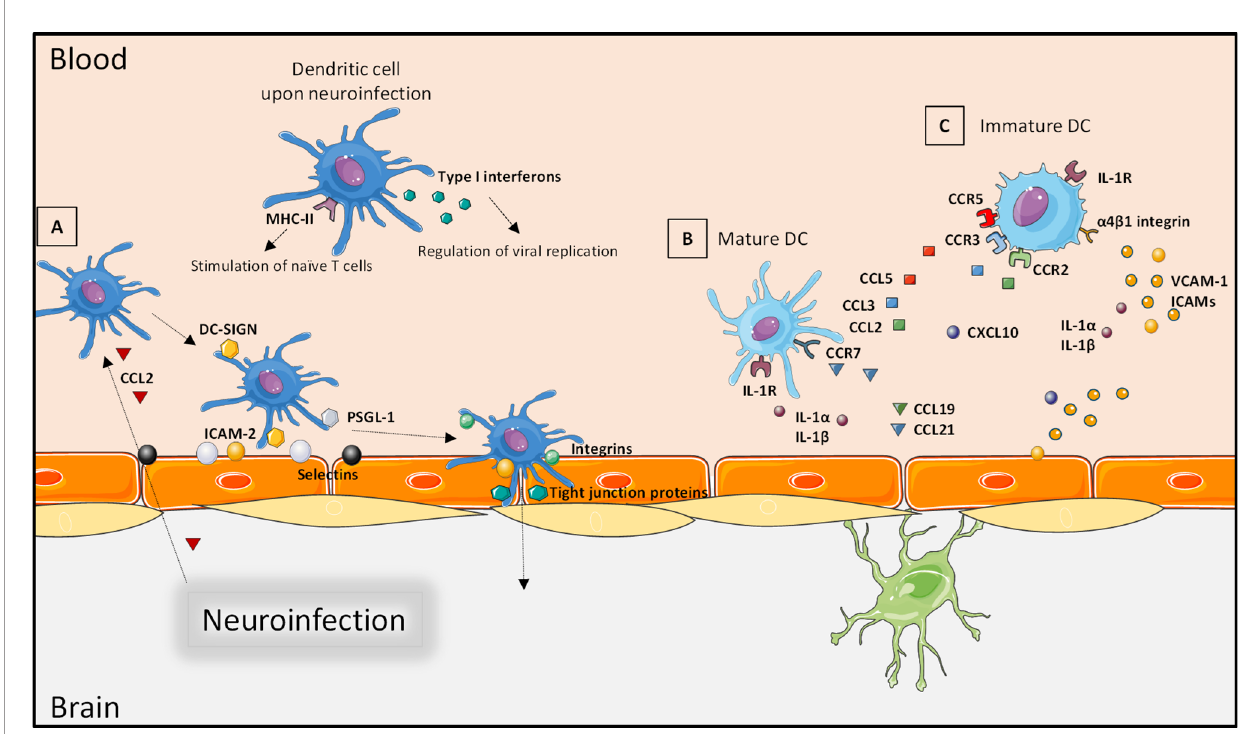
FIGURE 3 | Interaction of dendritic cells with the blood – brain barrier. Through the neuroinfection and the release of pro-in fl ammatory factors, DCs can produce type I interferon to regulate viral replication. Infected DCs can also act as antigen-presenting cells and stimulate T cells. (A) DCs are chemoattracted to brain barriers by circulating chemokines (such as CCL2); a fi rm contact is established by interaction of cellular adhesion molecules expressed by endothelial cells that facilitate rolling and adhesion. Transmigration occurs as an interaction of cellular adhesion molecules and integrins. (B) The recruitment of mature DCs is facilitated by expression of CCR7 and IL-1R that increases attraction by secreted CCL19, CCL21 or IL-1 a and IL-1 b , respectively. (C) Immature DCs can also be attracted by interaction of IL-1 a or IL-1 b with IL-1R, but their expression of CCR2, CCR3, and CCR5 increases the interactions with CCL2, CCL3, and CCL5. Created with SMART Servier Medical